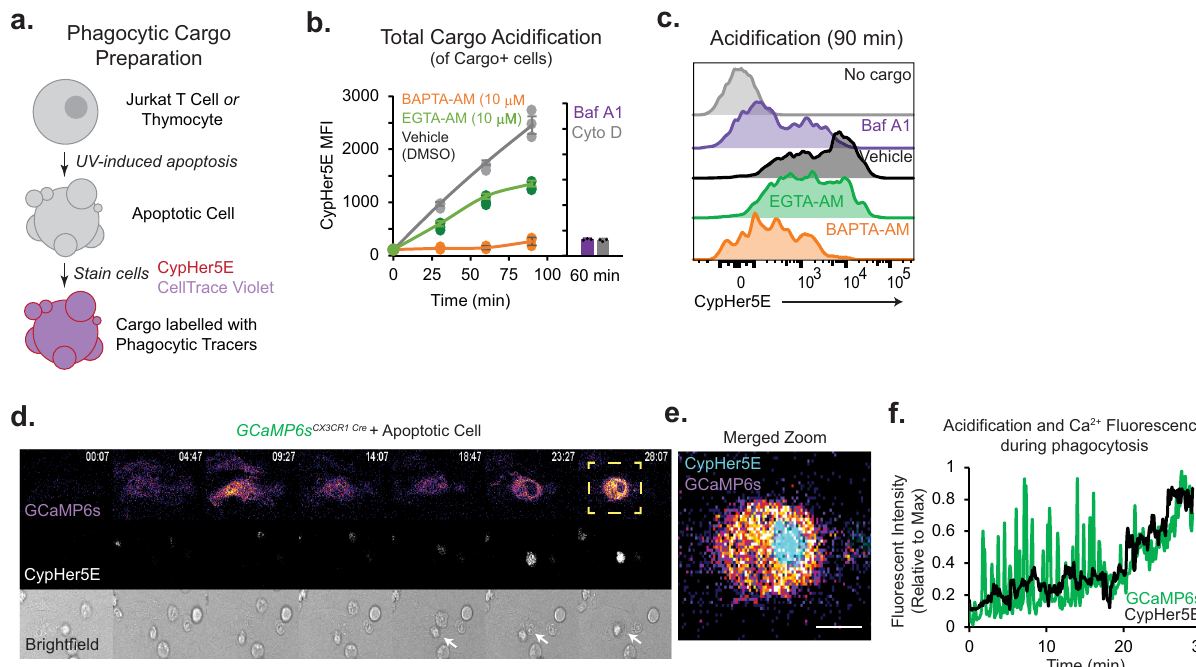
Fig. 1 Ca 2 + signaling requirements of phagosome acidi fi cation. a Preparation of apoptotic cell cargo is schematized. UV-irradiated apoptotic cells are stained with pH-insensitive (CellTrace Violet) and pH-sensitive (CypHer5E) dyes to measure cargo association and acidi fi cation, respectively. Apoptotic cells are then offered to macrophages by centrifugation, and unengulfed cells are removed by trypsinization and washes in Ca 2 + -free saline. b Flow cytometry-based measurement of acidi fi cation of phagosomes after engulfment of apoptotic cell cargo by BMDMs loaded with vehicle (DMSO), BAPTA- AM or EGTA-AM (both 10 μ M, 30 min). Engul fi ng CD11b + BMDMs containing labeled cargo (CellTrace Violet) were gated and analyzed for acidi fi cation (CypHer5E fl uorescence). Ba fi lomycin A1 (BafA1; 500 nM) and Cytochalasin D (Cyto D; 1 μ M) treated cells were used as negative controls. Data points indicate independent samples from different animals; bar charts represent mean value (Error bars = SD). p < 0.001 for all statistical comparisons between treatment conditions by two-way ANOVA (by Time and Treatment [F(4,12) 30.79)] with Bonferroni ’ s correction). c Representative histograms showing phagosome acidi fi cation after 90 min of phagocytosis. Data are representative of biological triplicate samples described in b . d [Ca 2 + ] i dynamics in GCaMP6s-expressing BMDMs during phagocytosis of apoptotic Jurkat cells. GCaMP6s (top image; Fire LUT), CypHer5E fl uorescence (middle; gray), and bright fi eld (bottom image; gray) were acquired using wide- fi eld microscopy (1 frame/7s). Region of interest (ROI) shown in yellow box is magni fi ed in panel e . White arrows indicate engulfed cell. See also Supplementary Movie 1. e ROI outlined in panel d . is shown as a merged image of GCaMP6s (Fire LUT) and CypHer5E (Cyan) fl uorescence, 28 min after the addition of apoptotic cells to BMDMs. Scale bar is 10 μ m. f Quanti fi cation GCaMP6s (green trace) and CypHer5E (black trace) fl uorescence intensity over time. Measurements are from data depicted in panel d over time. Source data are provided as a Source Data fi le, and statistical testing is described in “ Statistics and Reproducibility ”